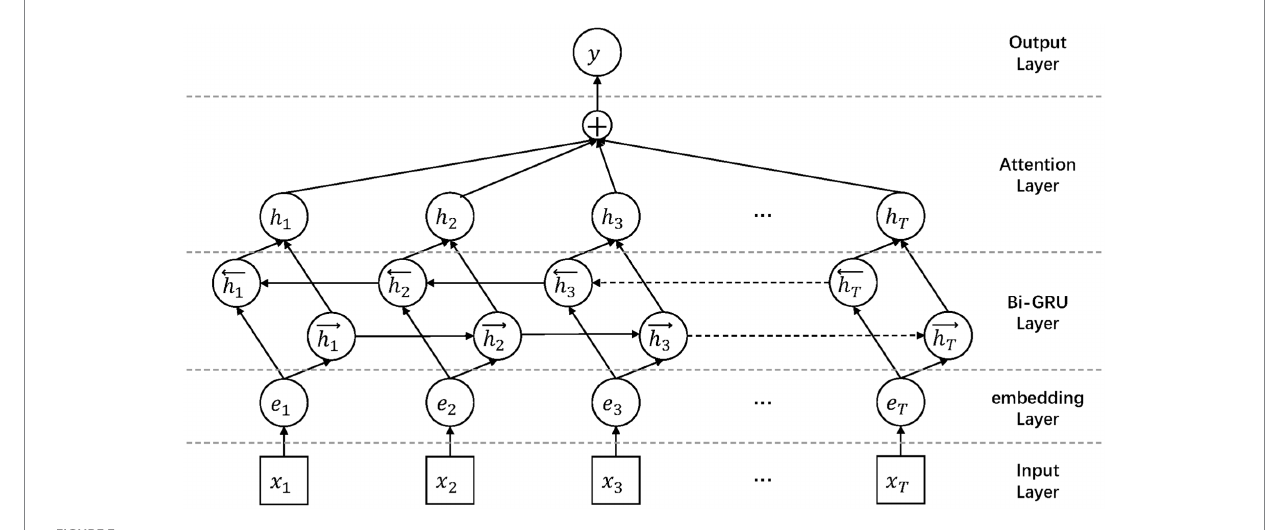
FIGURE 3 BiGRU-Attention classification model